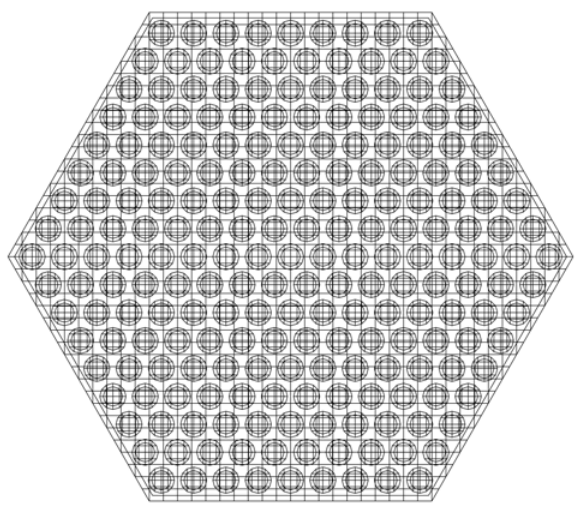
Figure 5. Mesh of the investigated case (the orthogo- nal mesh of the fuel pin is 4x4 and the mesh for whole fuel assembly is